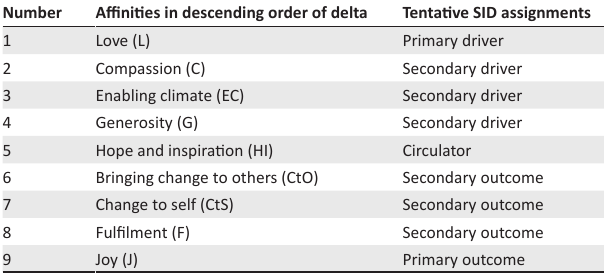
TABLE 3: Tentative